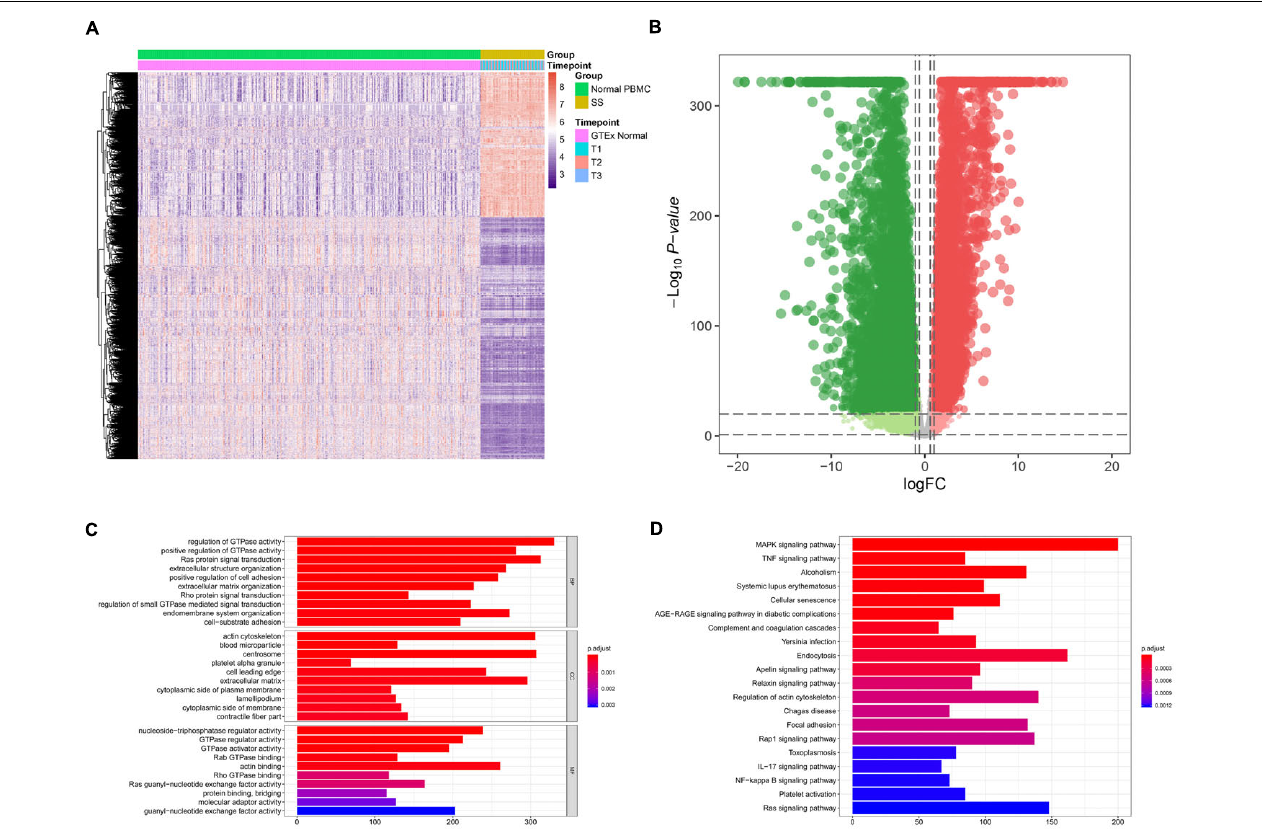
FIGURE 2 | Identification of differential expression genes (DEGs) between 63 septic shock blood samples and 337 normal whole blood samples and functional annotation. (A) Heat map showing the expression level of DEGs. A total of 14,843 genes (9,402 down-regulated genes and 5,441 up-regulated genes) were identified as DEGs. (B) Volcano plot showing the differential expression patterns of DEGs, where green dots refer to down-regulated genes while red dots refer to up-regulated genes. (C) The output of Gene Ontology (GO) analysis. The most significant enrichment items of BPs, CCs, and MFs in GO analysis for DEGs were regulation of GTPase activity, actin cytoskeleton, nucleoside-triphosphatase regulator activity. (D) The output of Kyoto Encyclopedia of Genes and Genomes (KEGG) pathways enrichment analysis. The most significant KEGG pathway where DEGs mainly enriched was MAPK signaling